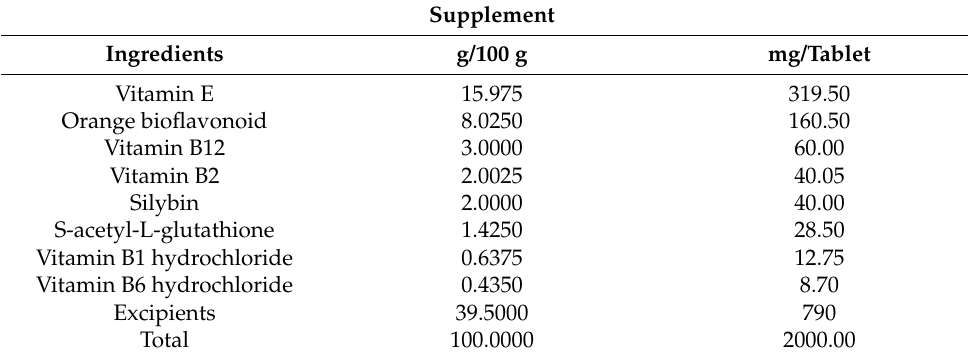
Table 1. Ingredients of the tested